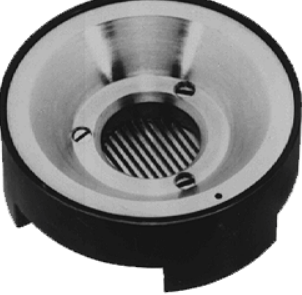
Fig. 11. Electrostatic actuator used for frequency response calibration of WS1 microphones. Actuators are standardised by IEC and are widely used for calibration of working standard microphones. They can excite the microphone diaphragms with constant electrostatic pressure over very wide frequency ranges.